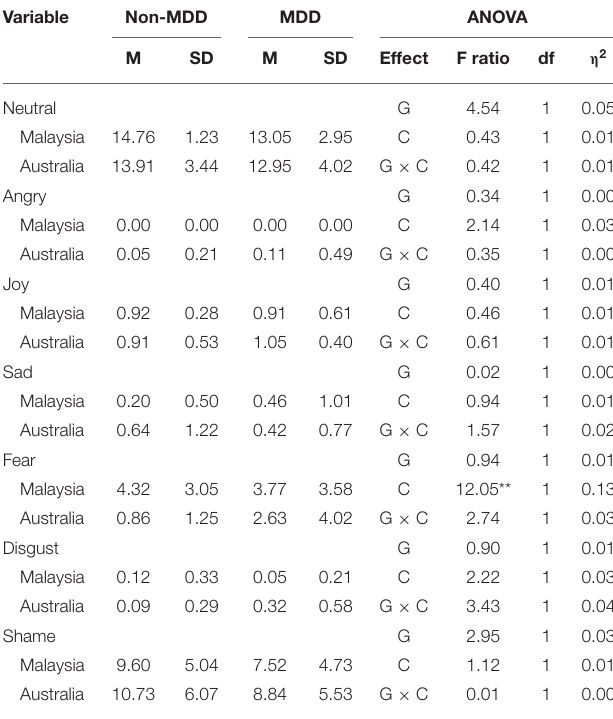
TABLE 2 | Means, Standard Deviations, and Multivariate ANOVA Statistics for Malaysian and Australian participants with and without MDD according to the type of